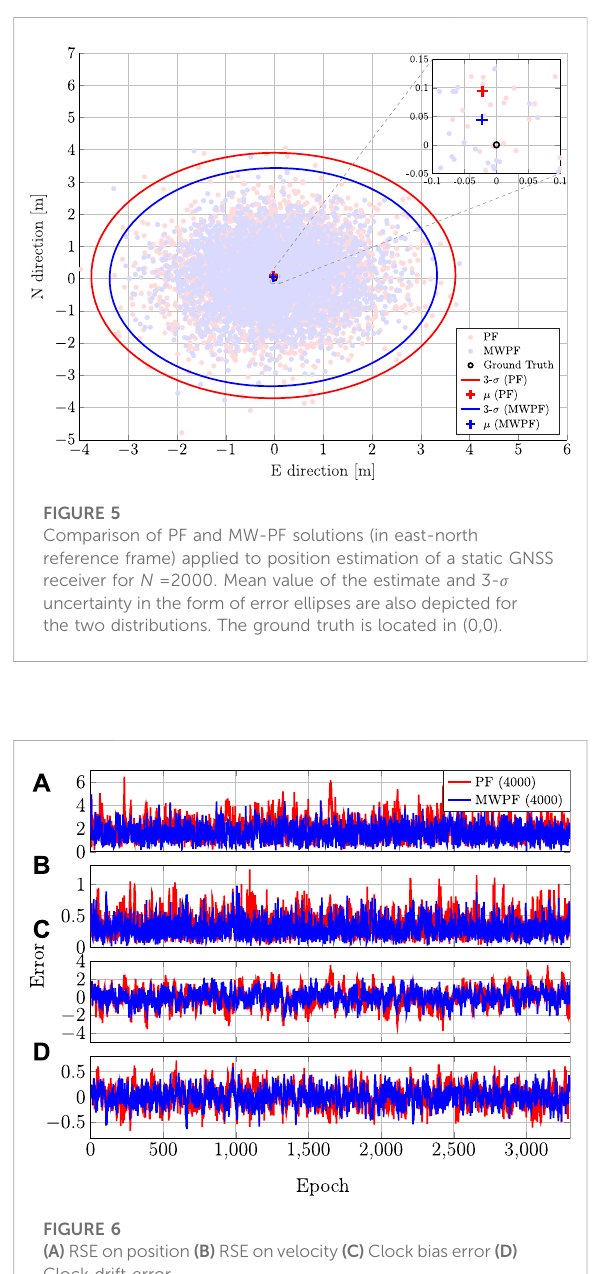
FIGURE 6 (A) RSEonposition (B) RSEon velocity (C) Clock bias error (D) Clock drift